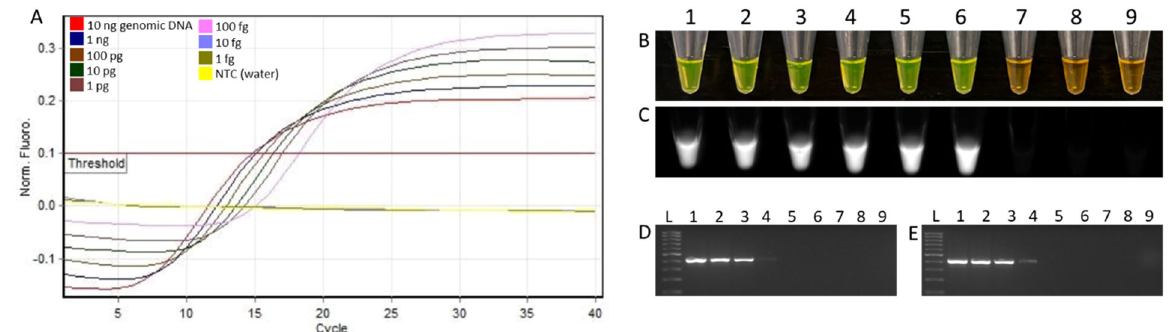
Figure 4. Detection limit determination of loop mediated isothermal amplification (LAMP) assay designed for specific detection of Dickeya fangzhongdai. Purified genomic DNA (CFBP8607 T ), serially diluted tenfold (from 10 ng to 1 fg) was used per reaction (tubes 1–8), with tube 9 being non-template control (NTC) water. ( A ) Sigmoidal curves; ( B ) results after adding SYBR Green I dye to the amplified reaction—a color change from orange to bright green indicates a positive amplification; ( C ) tubes observed under UV light—fluorescence is indicative of positive amplification. Positive amplification with the LAMP assay was observed for concentrations as little as 100 fg (tube 6). ( D ) Endpoint sensitivity assay with genomic DNA, serially diluted tenfold (from 10 ng to 1 fg); ( E ) spiked assay (1 µl of healthy taro corm genomic DNA was added in tenfold serially diluted genomic DNA). In both cases, endpoint PCR was 100-times less sensitive than the LAMP assay.